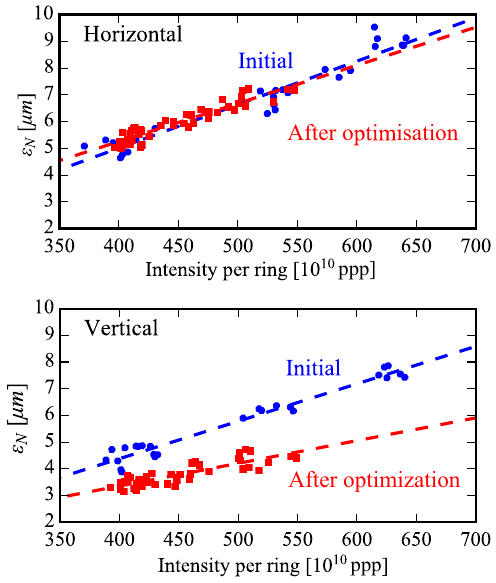
FIG. 2. Measured transverse normalized emittances in the PSB as a function of bunch intensity. The situation for the standard setup ( “ Initial ” ) as well as the special one ( “ After optimization ” ) is shown and proves the reduced dependence on intensity of the vertical emittances for the special configuration. The emittance is expressed as 1 σ normalized value.